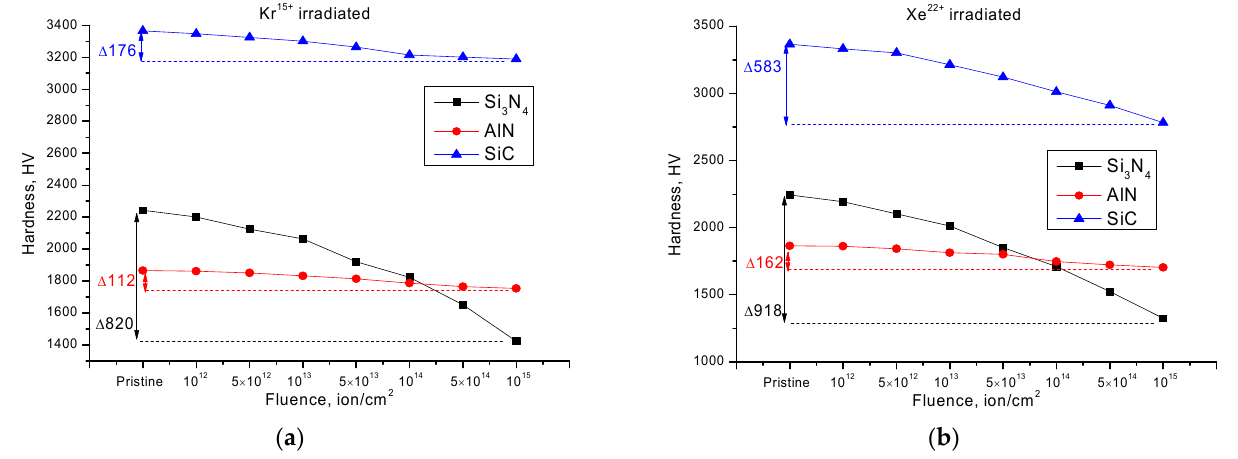
Figure 1. Results of changes in the hardness values of the investigated ceramics depending on the type of incident ions: ( a ) irradiation with Kr 15+ ions; ( b ) irradiation with Xe 22+ ions. It is also worth noting that for Si 3 N 4 ceramics irradiation with Kr 15+ and Xe 22+